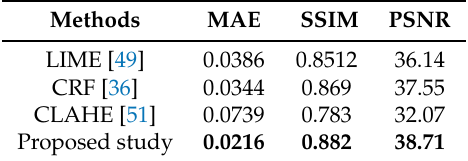
Table 4. Contrast performance between the compared